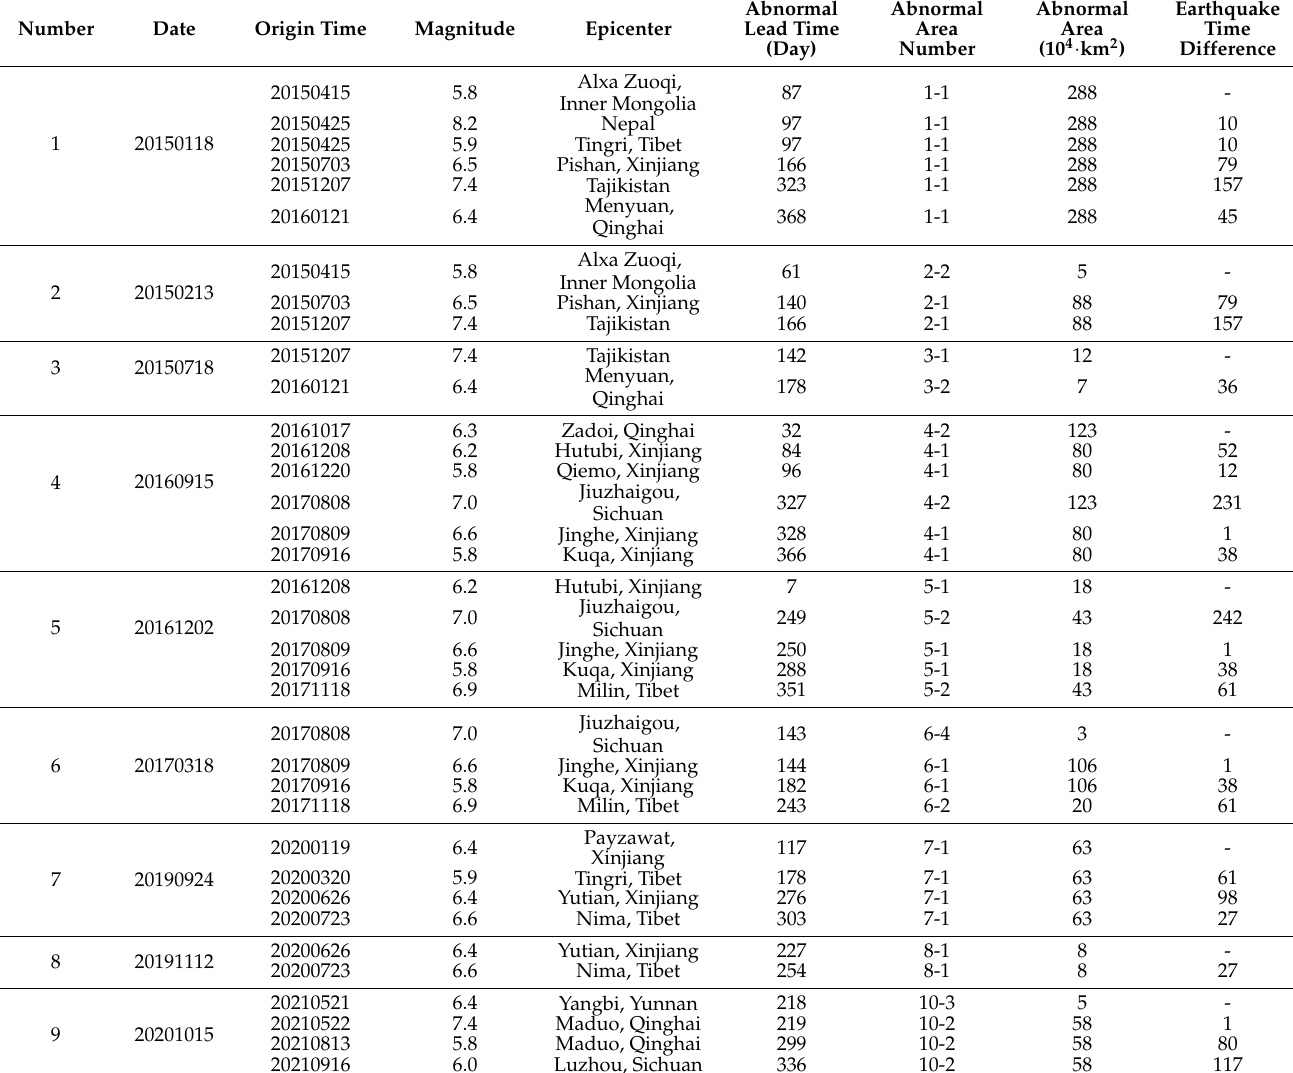
Table 1. Geomagnetic vertical intensity polarization anomalies and spatial distributions of earth- quakes in the following